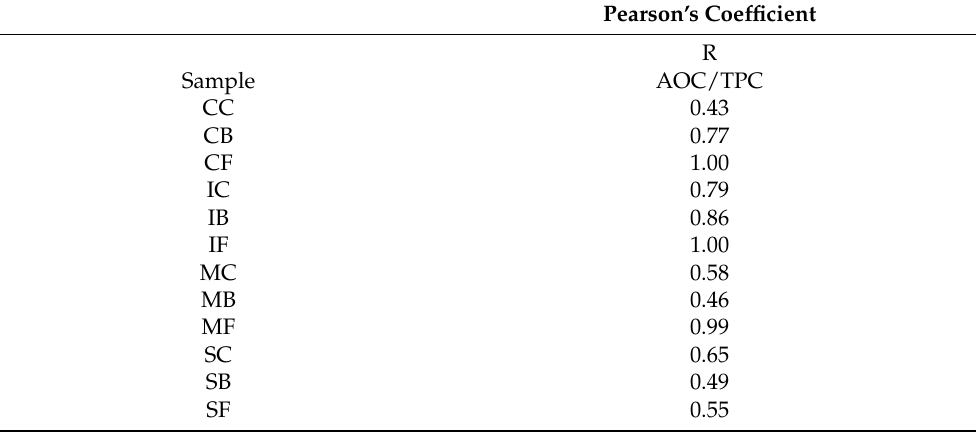
Table 2. Pearson’s coefficient values of the analysed chestnuts (boiled, raw, and